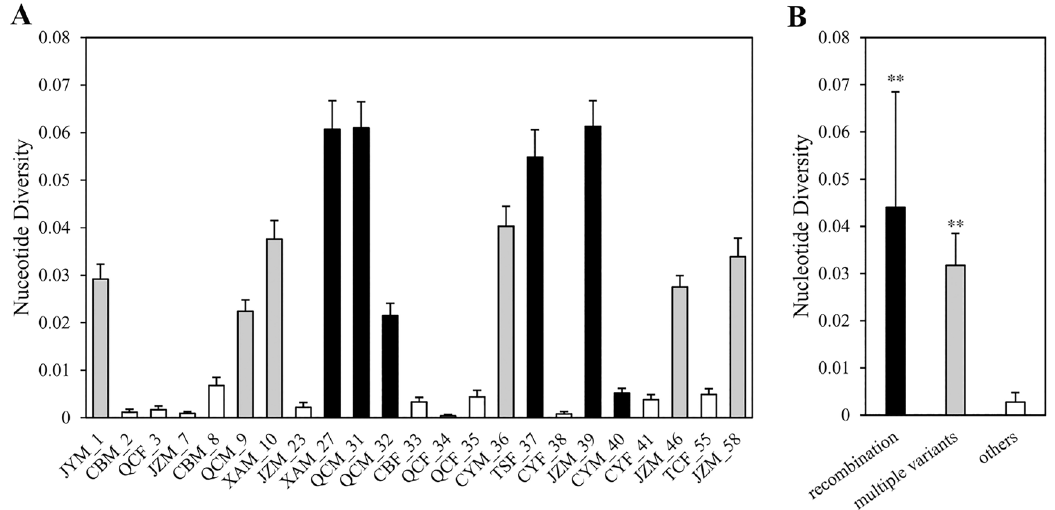
Fig 3. Nucleotide diversity of each patient. The bar plots for each individual ( A ) and patient-specific group ( B ) show a relatively higher intra-host nucleotide diversity in patients detected with recombination sequences (black) or/and infected with multiple variants (grey) than other patients (white). Nucleotide diversity was evaluated regardless of